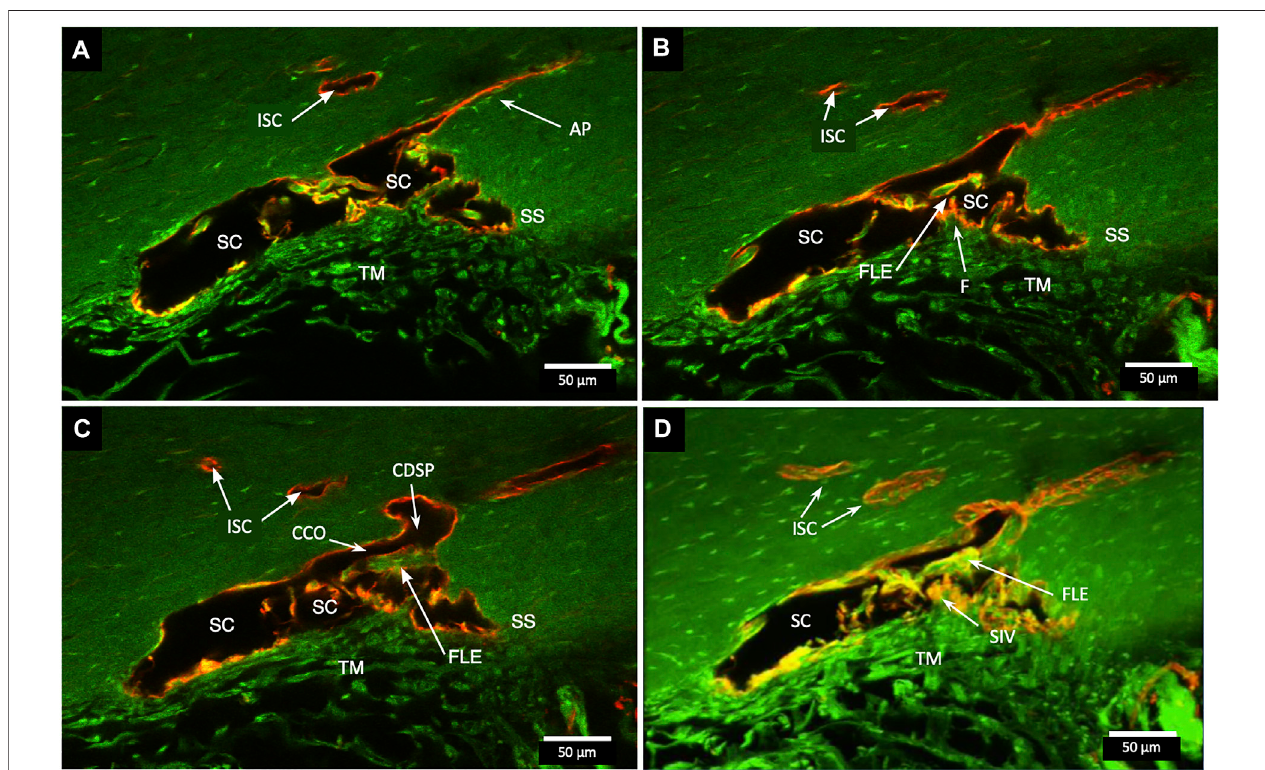
FIGURE 3 | Relationships of the trabecular meshwork and fl ap-like extensions at collector channels. (A – C) Merged confocal CD31 (red) and native fl uorescence (green)channel images demonstrate relationships ofthe trabecular meshwork(TM), Schlemm ’ scanal (SC), collector channels (CC), and fl ap-likeextensions(FLE) at CC ostia (CCO). Serial images demonstrate a funnel region (F) that becomes cylindrical, forming a SC inner wall valve-like structure (SIV) that attaches to a FLE at the SC external wall. A CCO is visible and distal to the FLE, and a deep scleral plexus (CDSP) is seen. In (A,B) , an SC area leading to an intrascleral channel (ISC) has two individual endothelial cell layers in apposition(AP) consistent witha closed potentialspace. TM attachments tothe scleral spur (SS)are visible (B,C) . (D) 3D projectionof the 22 µm 2D region in (A – C) demonstrates the complex intrascleral vasculature of the SC and ISC connection